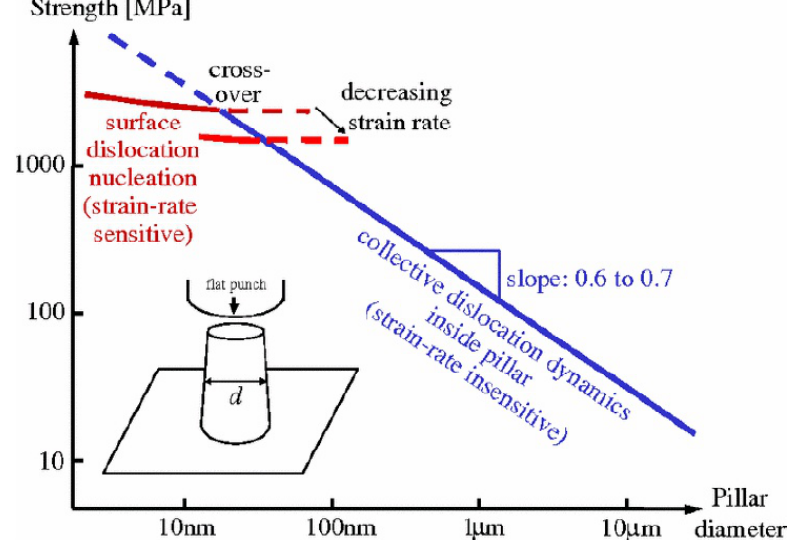
Fig. 14. Transition in the scaling behavior of yield stress on the sample size range of tens of nanometers. Reprinted with permission from Zhu T, Li J, Samanta A, Leach A, Gall K. 2008. Temperature and strain-rate dependence of surface dislocation nucleation. Physical Review Letters 100, [186]: (c) American Physical Society.